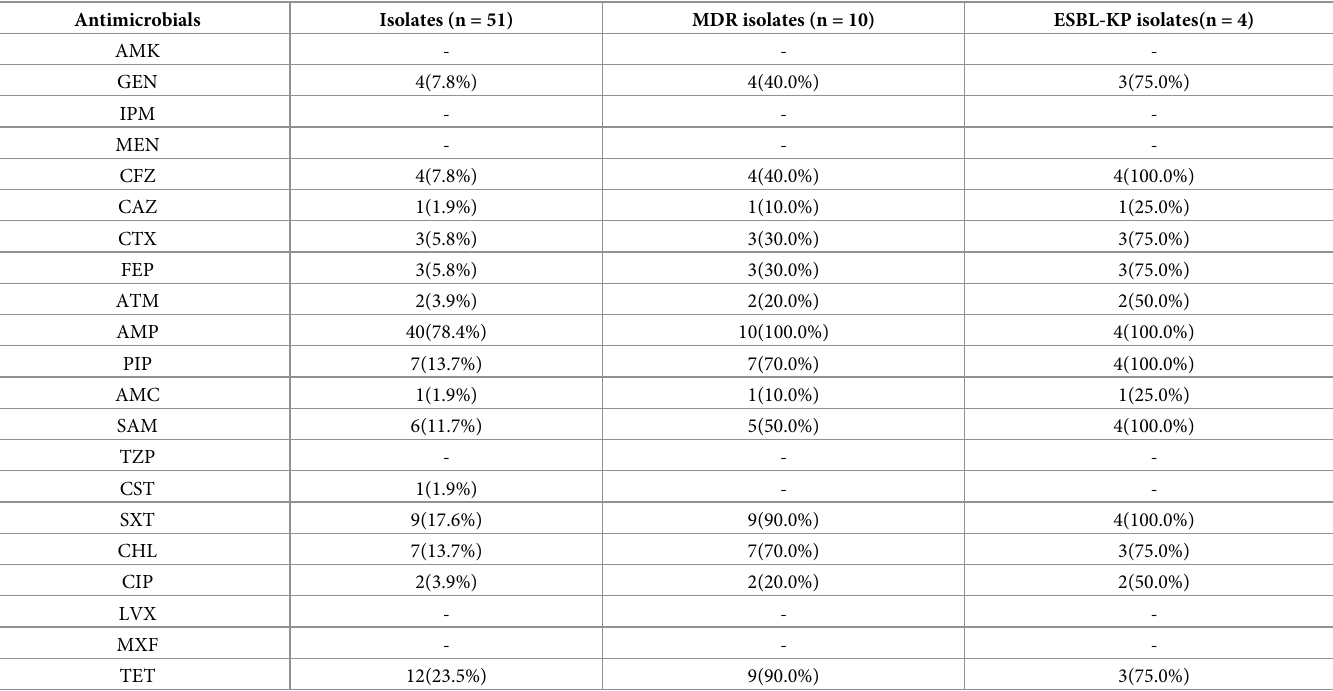
Table 2. Antimicrobial resistance of strains.